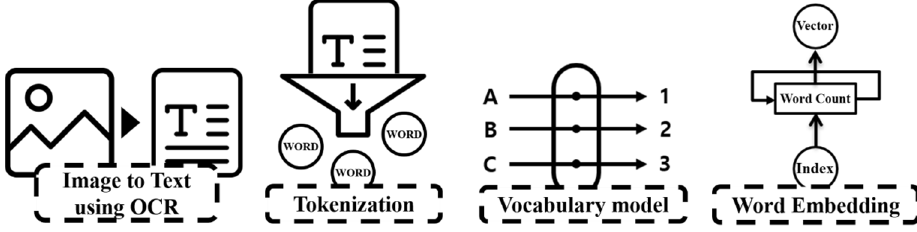
Figure 3. Process of the sub-model based on word embedding.